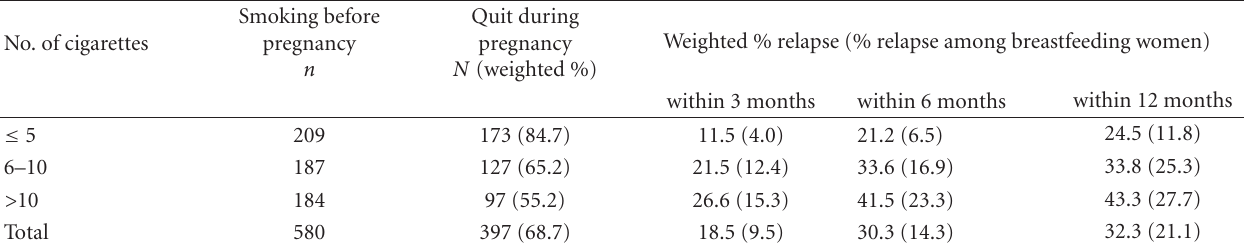
Table 2: Smoking behaviour description before, during, and after